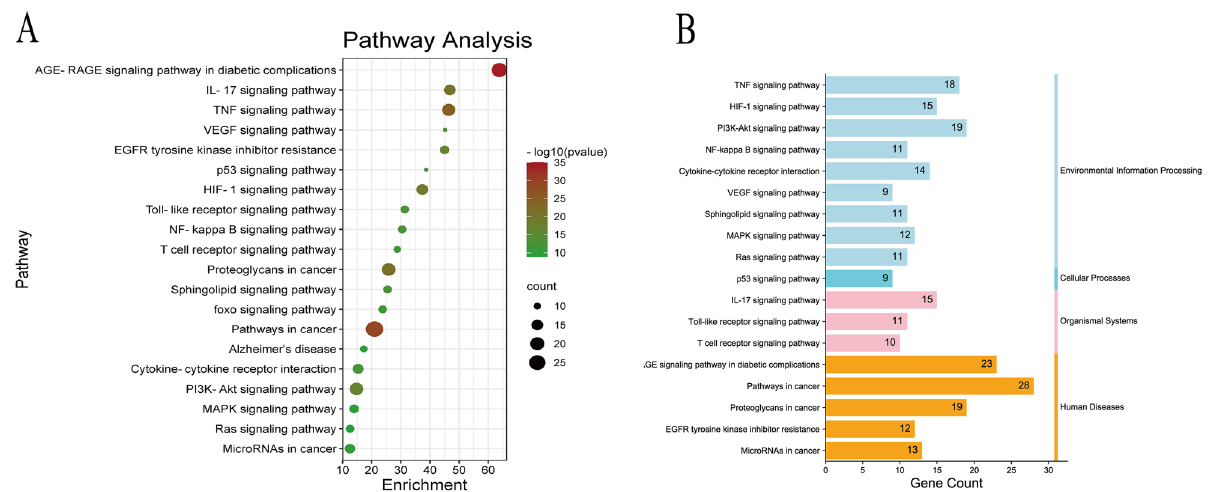
Figure 5. KEGG pathway enrichment analysis of quercetin targets relevant to T2DM and AD treatment. ( A ) KEGG pathway dot bubble plot. ( B ) KEGG pathway classification